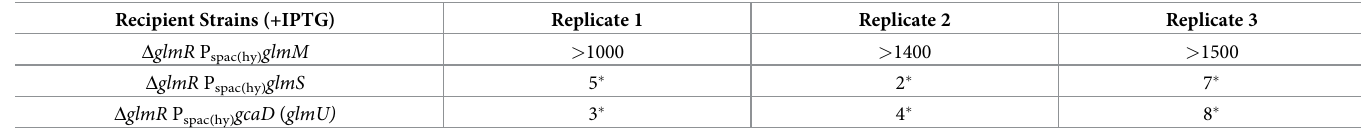
Table 3. Transformation of pgcA :: mls into recipient strains expressing PG biosynthetic enzymes induced with 1 mM IPTG 1 . Recipient Strains